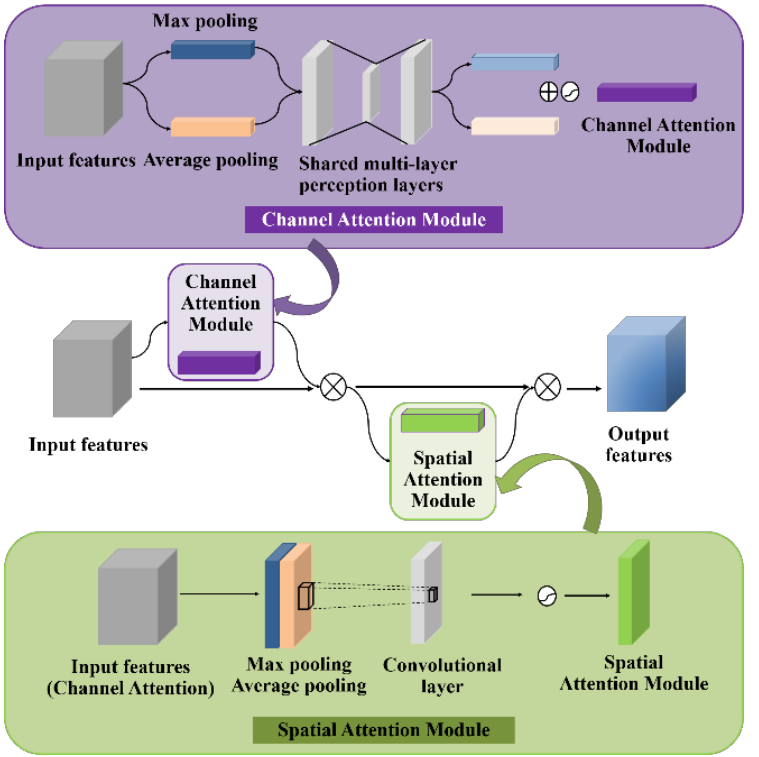
Figure 8. Convolutional block attention module.